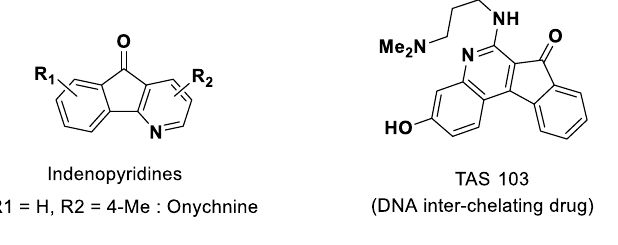
Figure 1. Examples of bioactive indenopyridines.